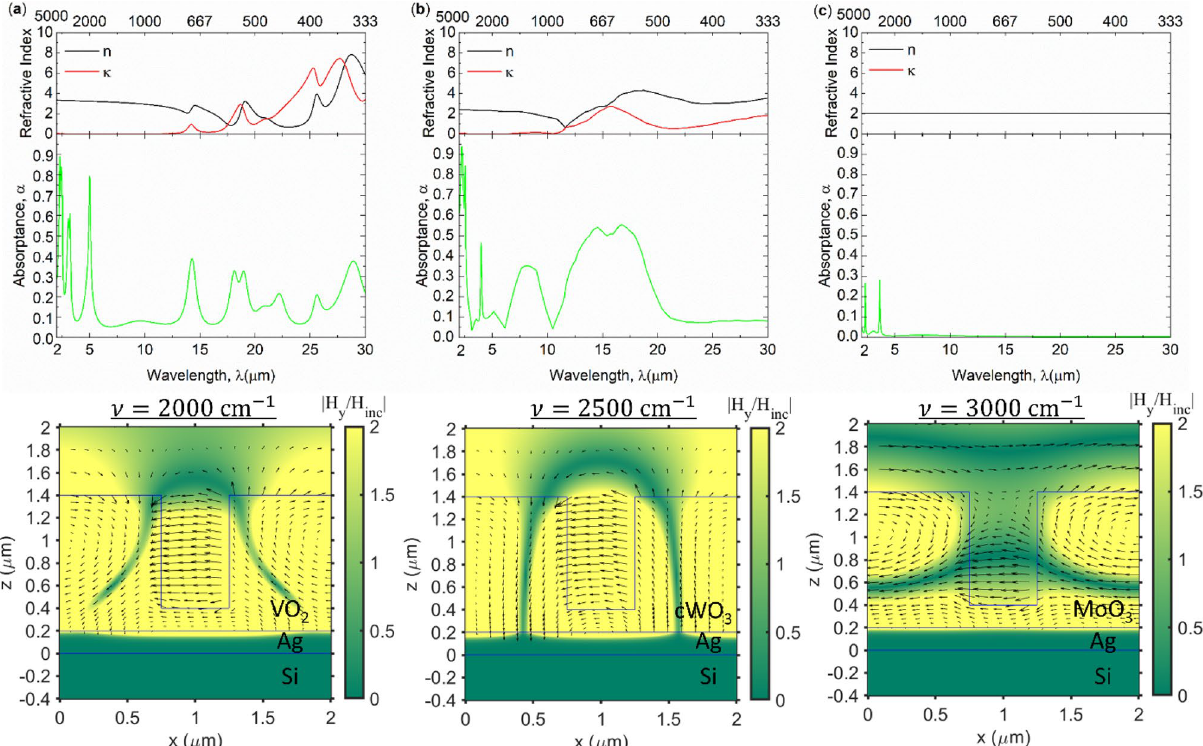
Figure 3. Refractive index n , κ , absorptance spectrum, and electromagnetic field contour of ( a ) VO 2 , ( b ) cWO 3 , and ( c ) MoO 3 at insulating phase (bleached) state. The magnetic field is shown in contour and black array shows the electric field vectors.